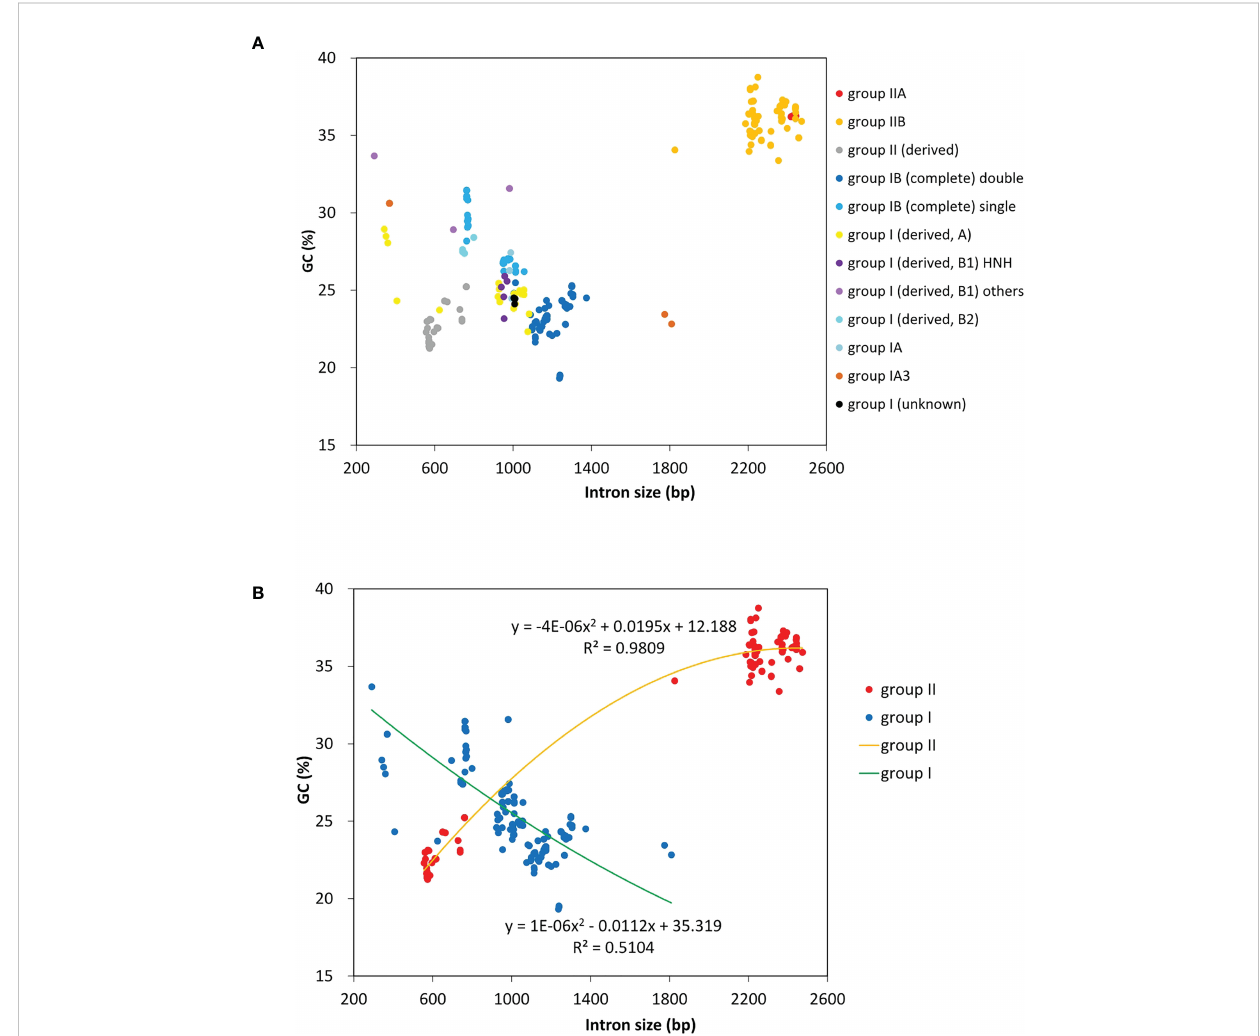
FIGURE 5 The GC composition and size of introns detected among 40 Ulva plastomes. (A) Comparison of GC content and size among different types of introns. (B) Comparison of GC content and size between group I and group II